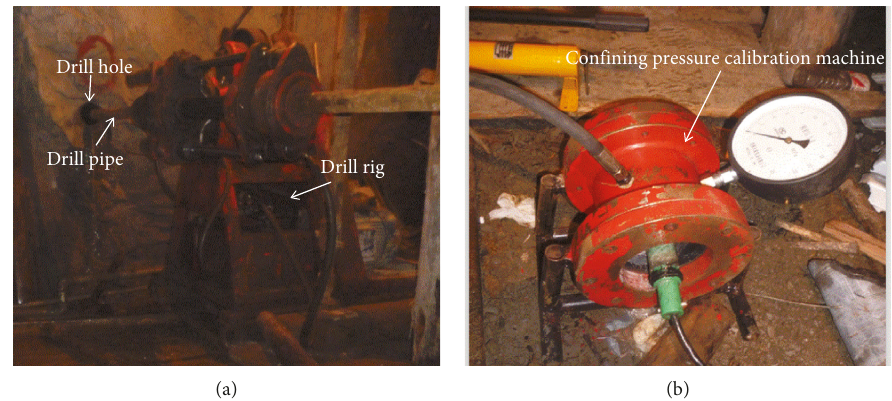
Figure 6: Stress relief tests. (a) Borehole overcoring. (b) Confining pressure calibration